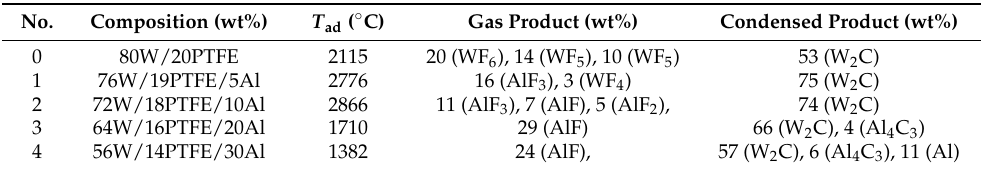
Table 2. Calculated combustion temperature and proportion of condensed products in the W/PTFE/Al